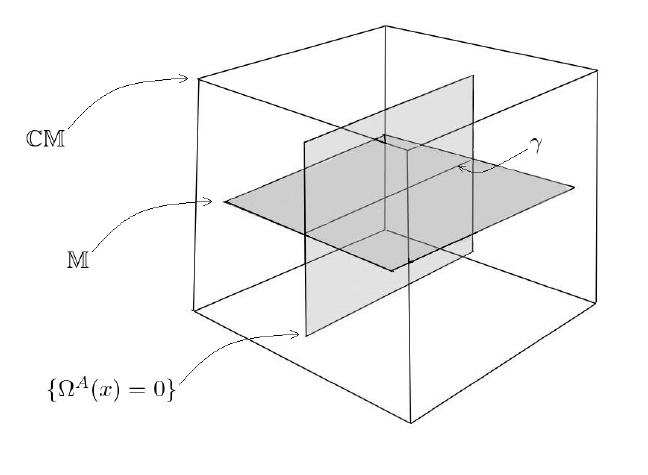
Figure 1: (cid:77) and an α -plane { Ω A ( x ) = 0 } as subsets of (cid:67)(cid:77) . Their intersection is a real light ray γ